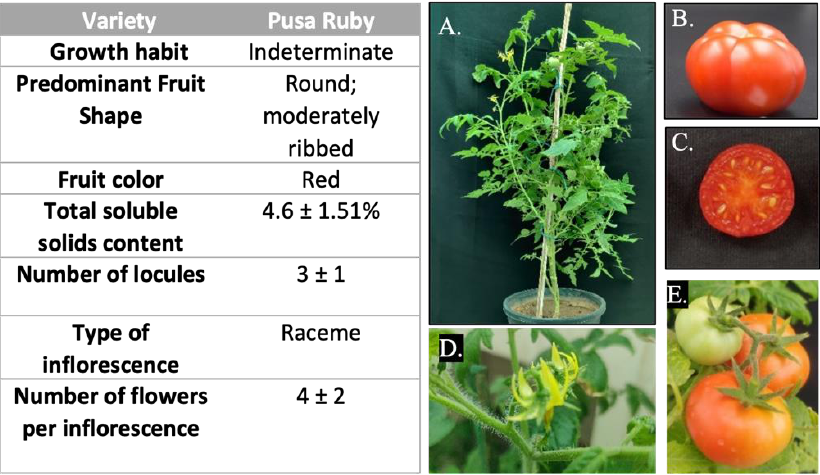
Figure 1. Morphological characteristics of S. lycopersicum cv. Pusa Ruby. The table on the left side describes the different phenotypic attributes of S. lycopersicum cv. Pusa Ruby. ( A ) Indeterminate growth habit of pusa ruby plants. ( B , C ) Red colored, and round fruits with slight ridges and 3 – 4 locules. ( D ) Raceme inflorescence is present in Pusa Ruby plants with non-synchronous fruit ripening, a characteristic of indeterminate plants. ( E ) Immature and ripening fruits on Pusa Ruby plant